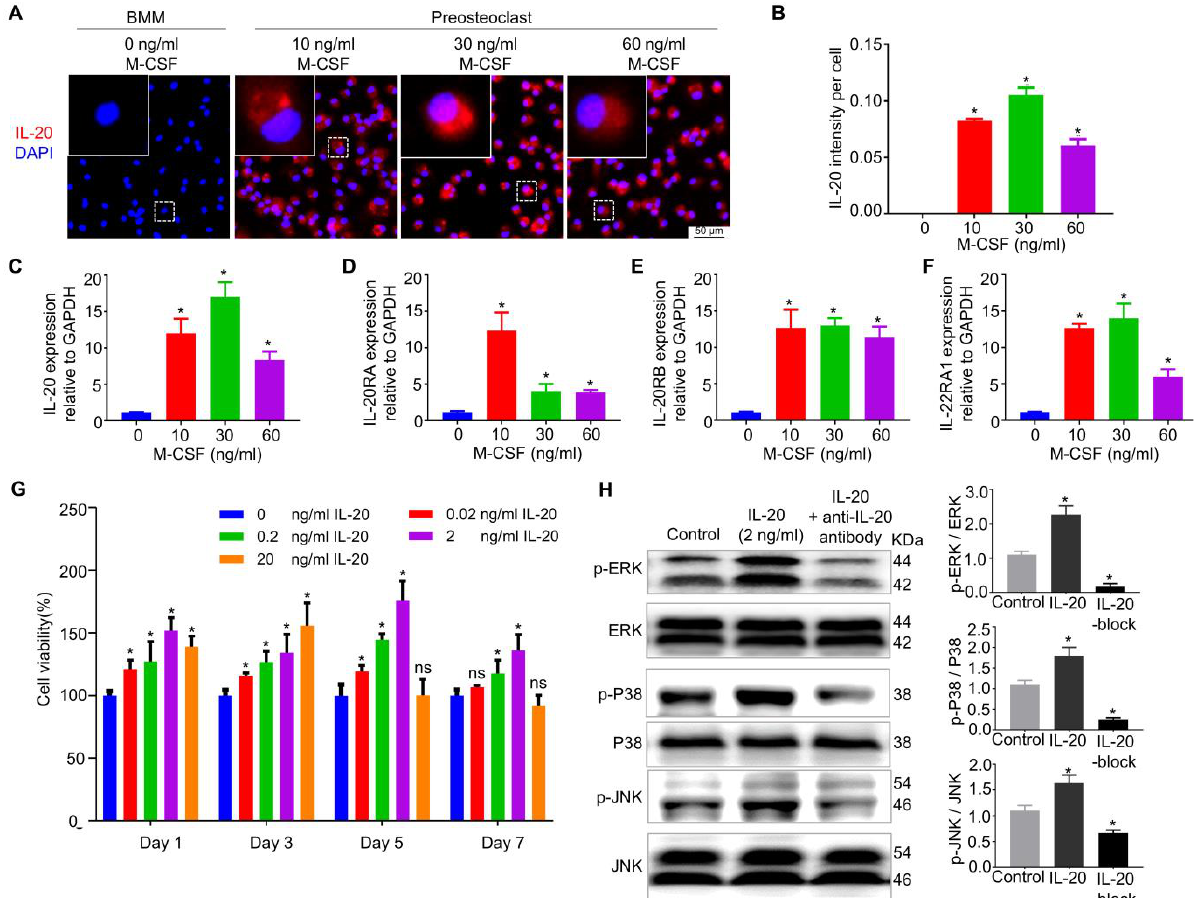
Figure 2. IL-20 promoted preosteoclast viability via MAPK pathway at the early stage of osteoclast differentiation. Cell viability was examined in M-CSF-induced preosteoclasts by a CCK8 assay. ( A , B ) The expression of IL-20 in M-CSF-induced preosteoclasts was determined by cellular im- munofluorescence staining on day 2. ( C – F ) The mRNA expression levels of IL-20, IL-20RA, IL-20RB, and IL-22RA1 in preosteoclasts were evaluated by qRT-PCR after 2 days of M-CSF treatment. ( G ) Cell viability detection in preosteoclasts treated with a gradient of concentrations of IL-20 on days 1, 3, 5, and 7. ( H ) Preosteoclasts were treated with 2 ng/mL IL-20 or anti-IL-20 antibody. The levels of phosphorylation of proteins in the IL-20-mediated signaling pathway, including p38, phos-pho-p38, ERK, phospho-ERK, JNK, and phospho-JNK, were analyzed using Western blotting. IL-20-block group meant that cells were treated with IL-20 and anti-IL-20 antibody. * p < 0.05 vs. the 0 ng/mL IL-20 group. ns p > 0.05 vs. the 0 ng/mL IL-20 group. n =